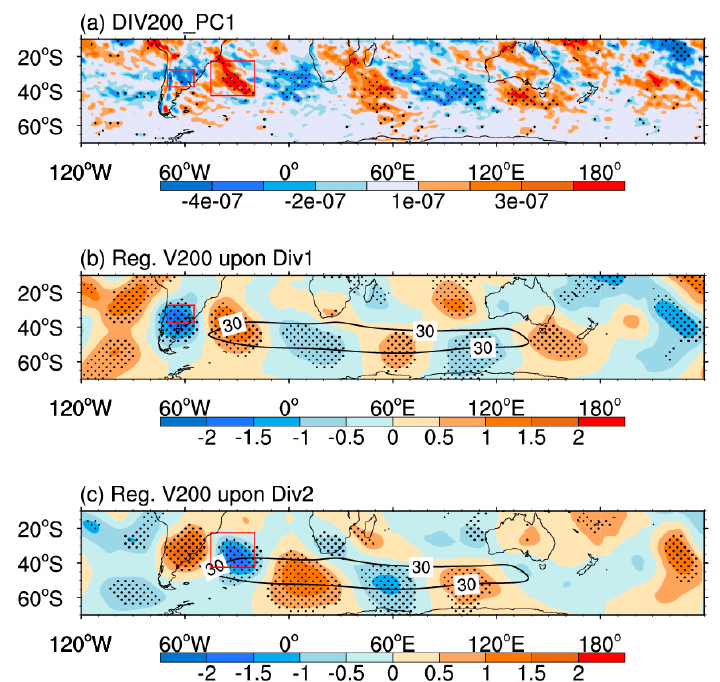
Figure 8. ( a ) As in Figure 2a, but for anomalies of divergence (unit: s − 1 ) at 200 hPa regressed upon the SAIO pattern. ( b – c ) Anomalies of V200 regressed upon the 200-hPa divergence over ( b ) mid-latitude South America (Div1, 27.5 ◦ –37.5 ◦ S, 55 ◦ –70 ◦ W) and ( c ) the southwest South Atlantic (Div2, 22.5 ◦ –42.5 ◦ N, 20 ◦ –45 ◦ W) depicted by the box. Dotted regions denote that the anomalies are significant at the 95% confidence level based on Student’s t -test and the contour depicts the Southern Hemisphere westerly jet.